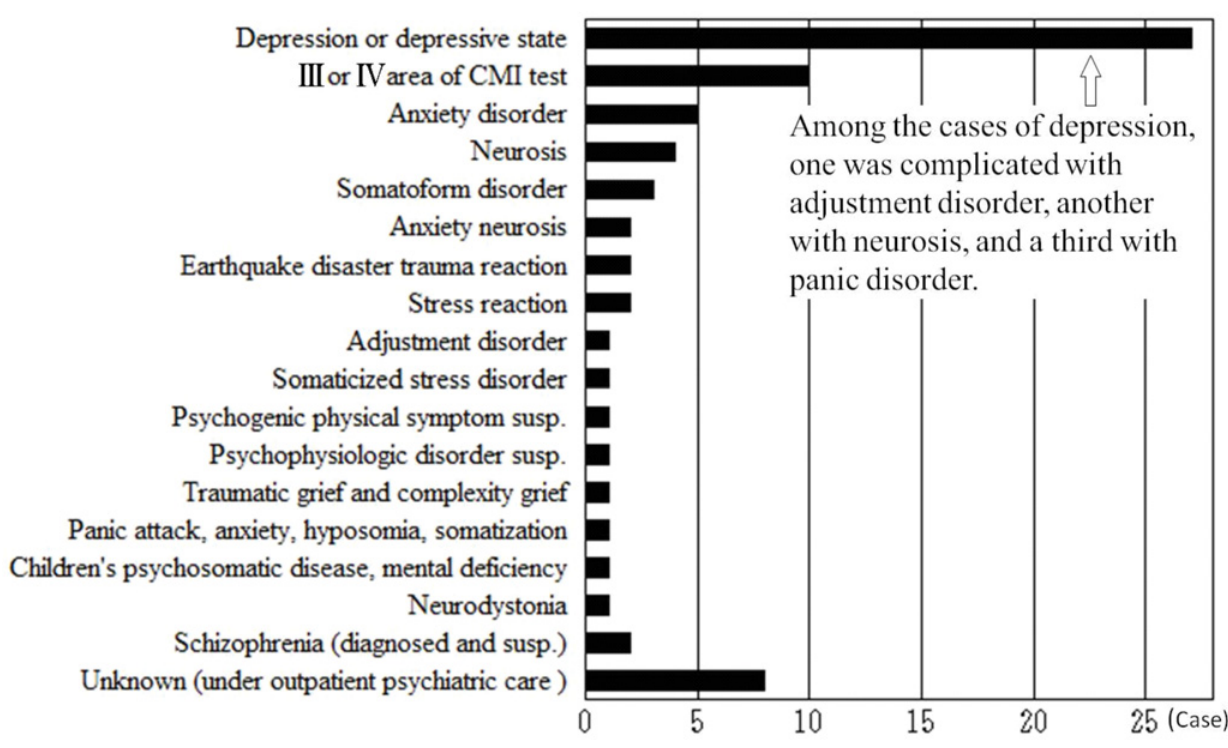
Fig 6. Diseases complicated with vertigo, MD, and ALHL. Depression and depressive type were the two diseases with the largest number of patients (27 cases). Other frequently seen diseases were anxiety disorder, neurosis, somatoform disorder, anxiety neurosis, adjustment disorder, and post-traumatic stress disorder